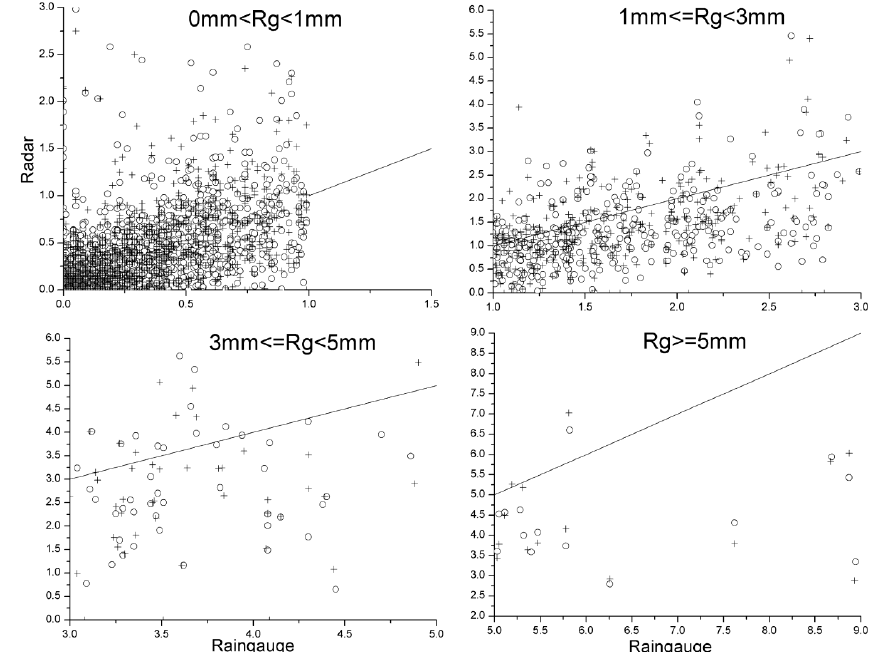
Fig. 6. 1h cumulative catchment rainfall distributions in different range based on the same data as in Fig. 5. Circles and crosses correspond Figure 6. 1-h cumulative catchment rainfall distributions in different range based on 744 to 5km/15min and 1km/5min radar rainfall estimates versus raingauge measurements respectively. the same data as in Fig. 5. Circles and crosses correspond to 5km/15min and 745 1km/5min radar rainfall estimates versus raingauge measurements respectively. 746